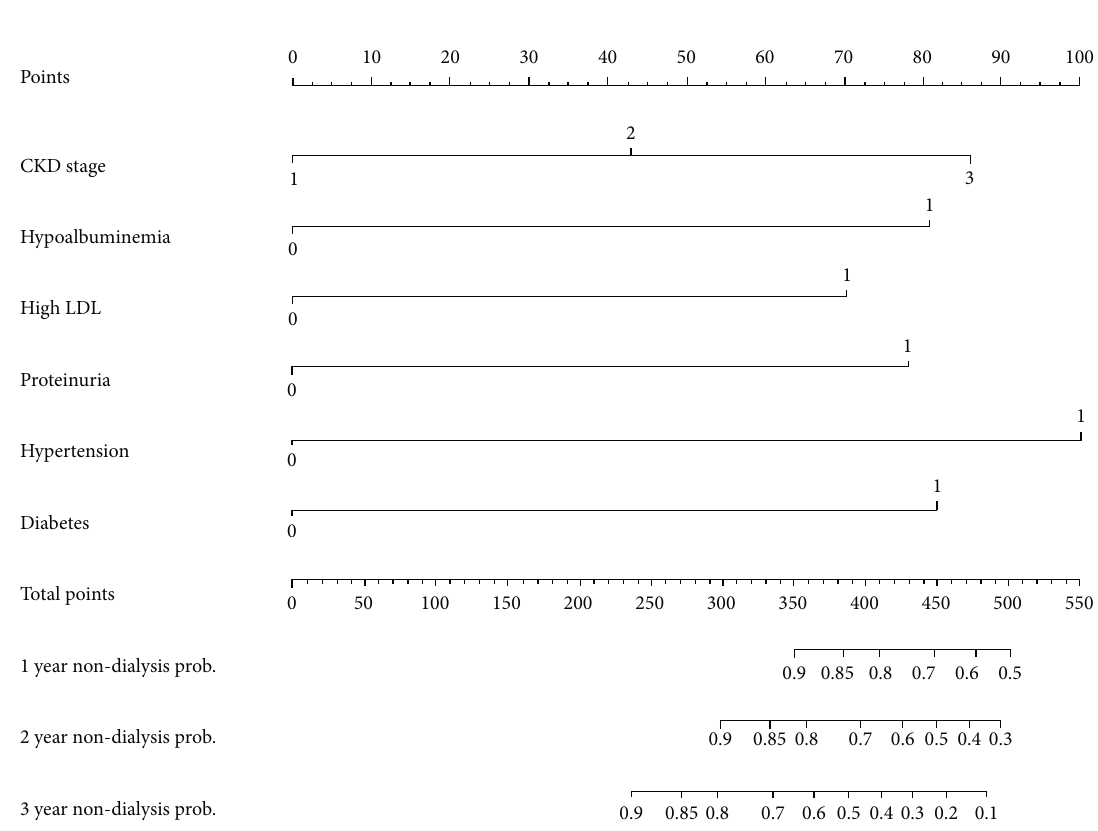
Figure 3: Prognostic nomograms. To use the nomogram, based on signi fi cant prognostic variables, draw upward lines from each variable axis to the points and calculate the sum of these points. And draw a downward line from total point axis to the non-dialysis axis to get the likelihood of 1 years non-dialysis prob., 2 years non-dialysis prob. and 3 years non-dialysis